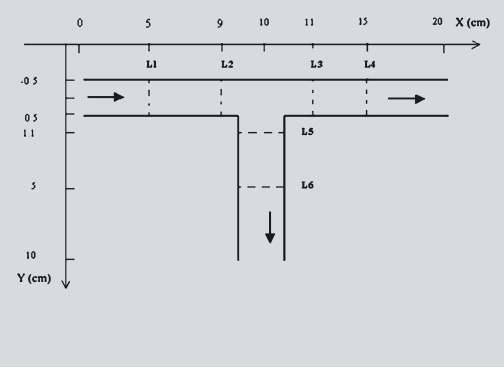
Figure 1 (left): Sketch of the flow geometry showing relevant dimen- sions and radial lines L1, L2, L3, etc. their axial velocity distribution is discussed. Figure 2: Comparison of viscosity Vs shear rate relationship as predicted by different blood constitutive equations.